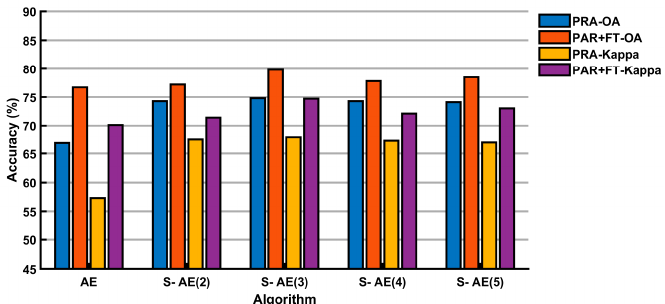
Figure 10. Classification accuracy with 1% pretraining samples.